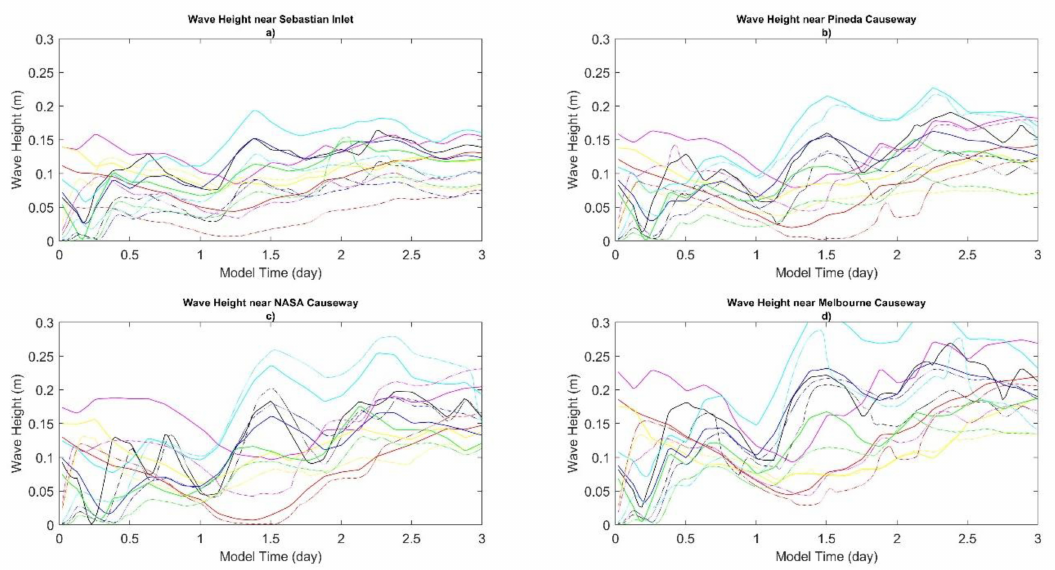
Figure A3. Time series plots of individual ADCparam and ADCIRC + SWAN ensemble members for wave height (meters) near ( a ) Sebastian Inlet, ( b ) Pineda Causeway, ( c ) NASA Causeway, and ( d ) Melbourne Causeway. The legend is shown in Figure A1. Each of these locations is selected based on location in the domain and associated fetches (station locations are specified in Figure